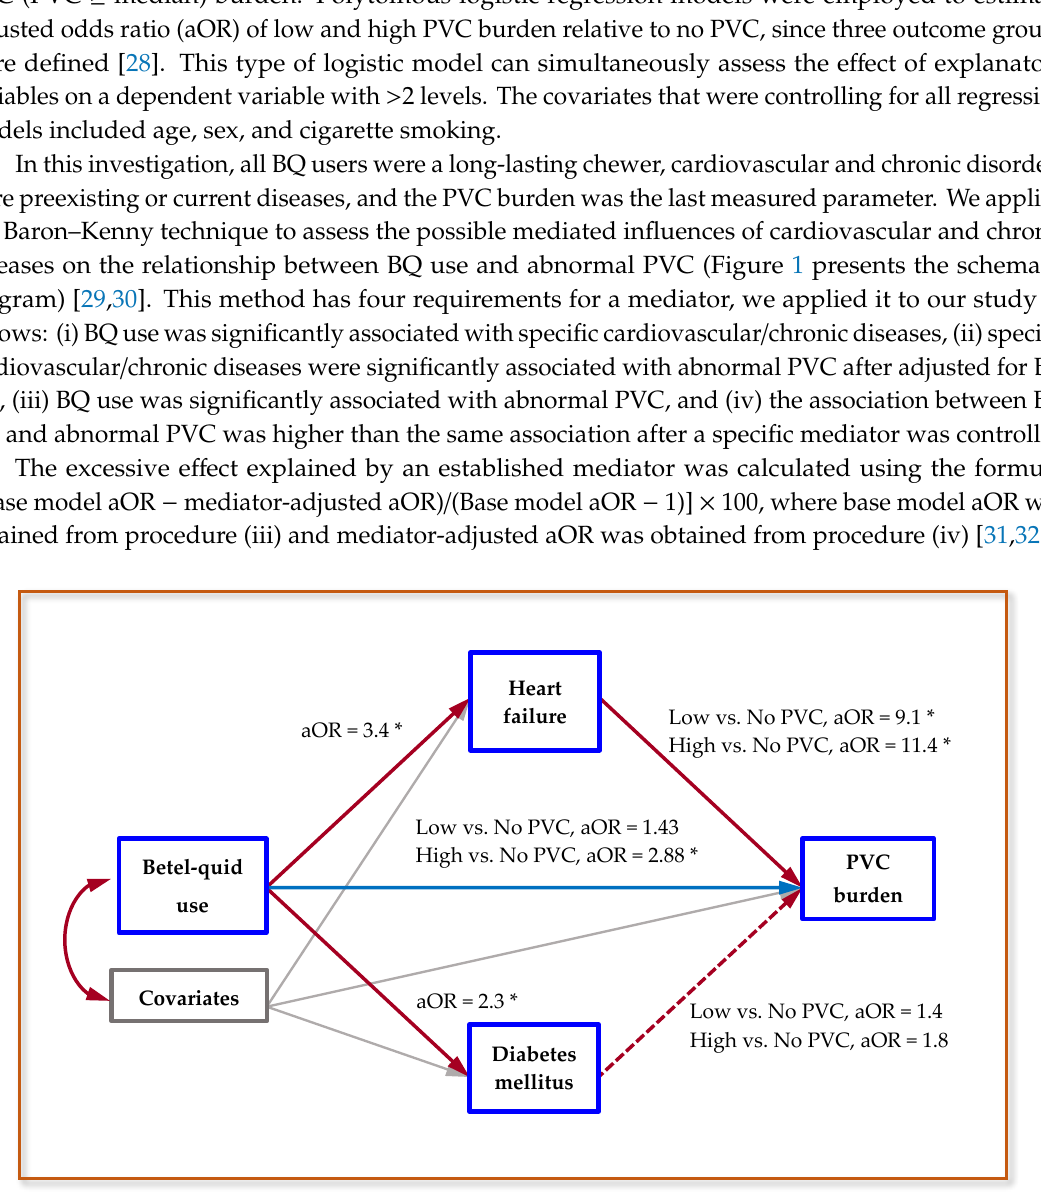
Figure 1. The schematic diagram of mediation analysis and summarized results between betel-quid use, heart failure, diabetes mellitus, and premature ventricular contractions (PVC) burden. Note : Covariates, including age, sex, and cigarette smoking, were adjusted for in all regression models. aOR denotes adjusted odds ratios, solid red lines represent a significant association, a dashed red line denotes a nonsignificant association, and a solid blue line reveals direct effect. * denotes p < 0.05.